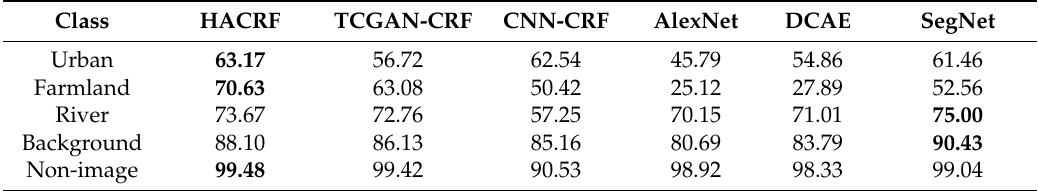
Table 4. Comparison of the pixel-wise F1 scores for individual classes with five state-of-the-art methods. Class HACRF TCGAN-CRF Farmland Background